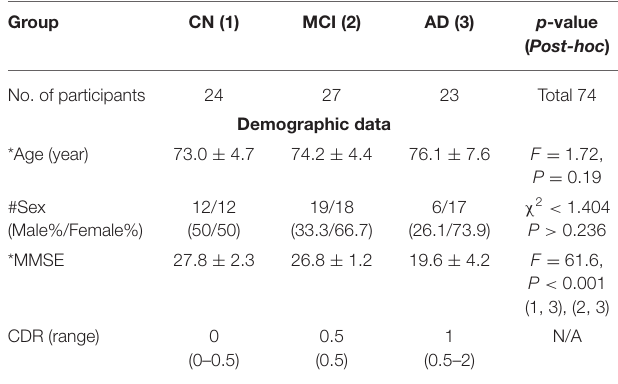
TABLE 1 | Comparisons of the demographic data and result of the neuropsychological tests among the three participant